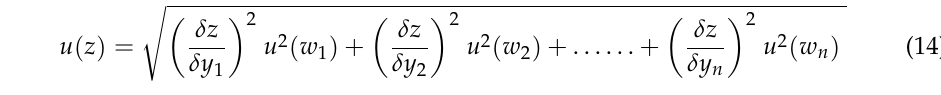
Table 2. Accuracies and uncertainties of various instruments. Instrument Range Accuracy Uncertainty, % − 20 °C ∼ 70 °C Digital Temperature Humidity Meter, °C, RH% AC/DC Digital Clamp Meter, V − 20 °C ∼ 70 °C ± 0.01% 0.01 TES 132 Solar Power Meter, W/m 2 − 0 ∼ 2000 W/m 2 Pro HVAC Anemometer Handheld CFM Meter Wind Speed Meter, m/s NTC single-end glass seal thermistor temperature